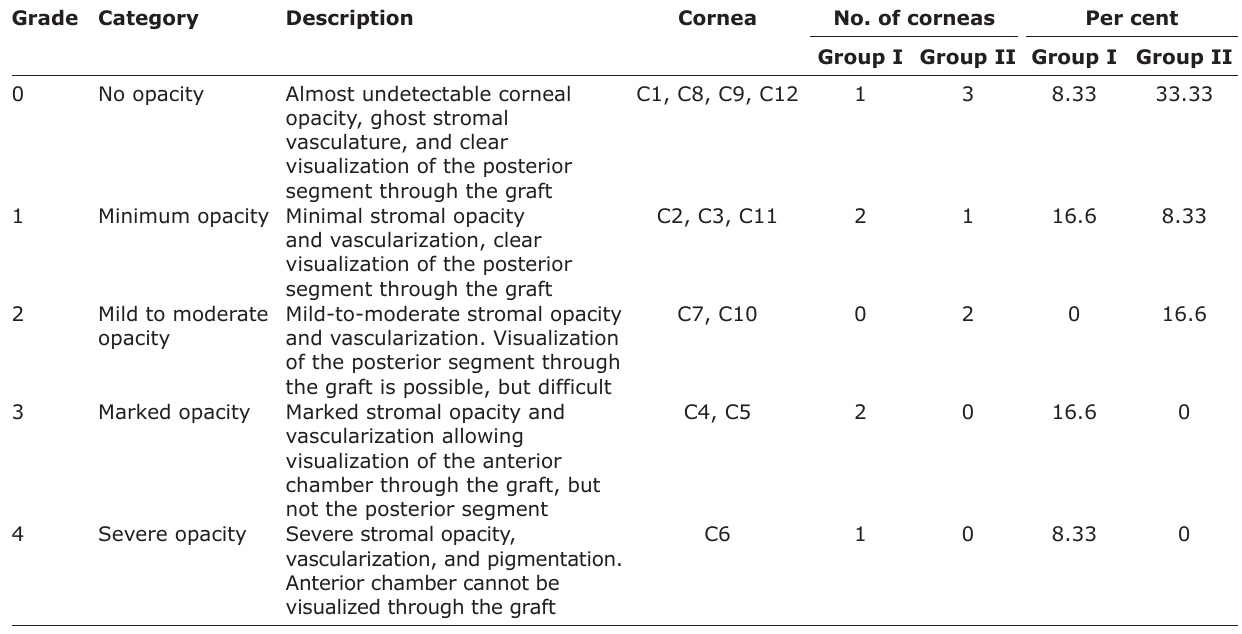
Table-1: Grading of corneal fibrosis/scarring at the end of observation period (day 60) in Group I and Group II animals. Grade